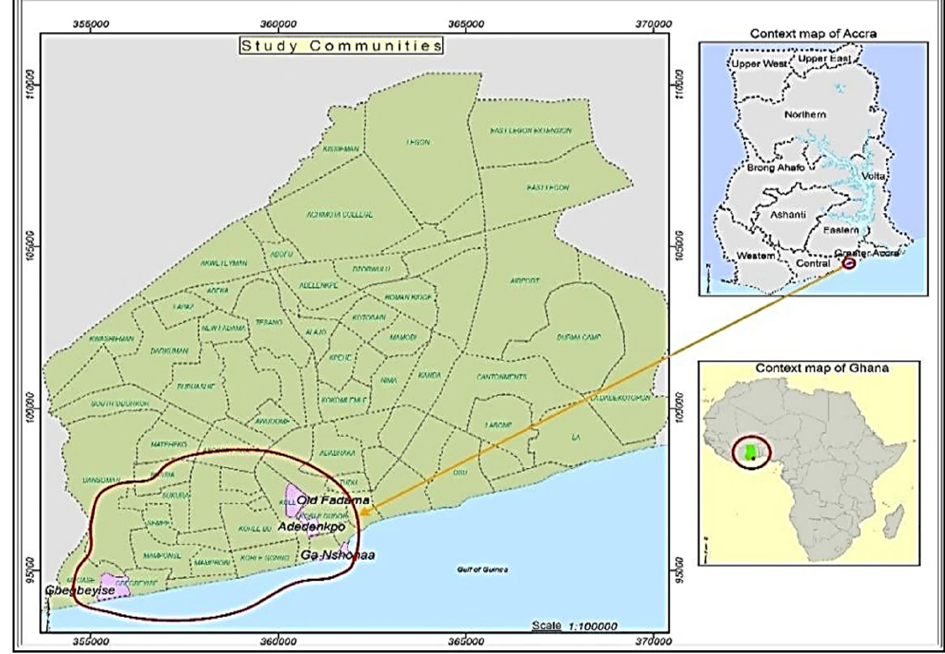
Figure 2. Map of Accra and Study Locations, Source: Authors’ construct.